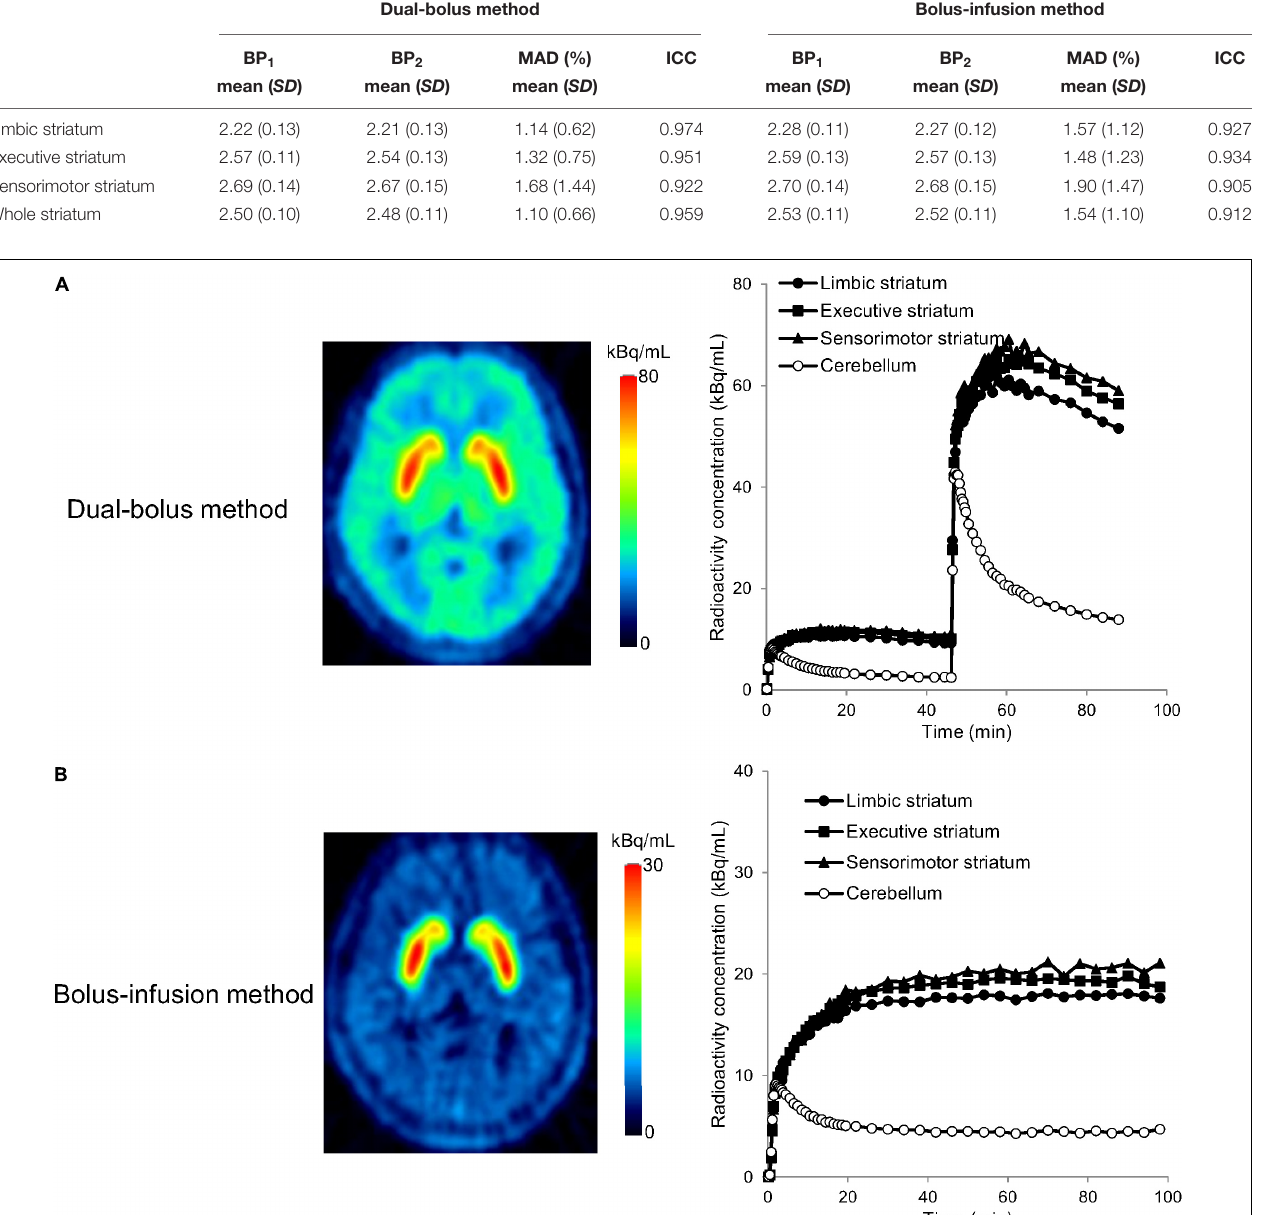
TABLE 1 | Changes in binding potential for PET studies without stimulation.